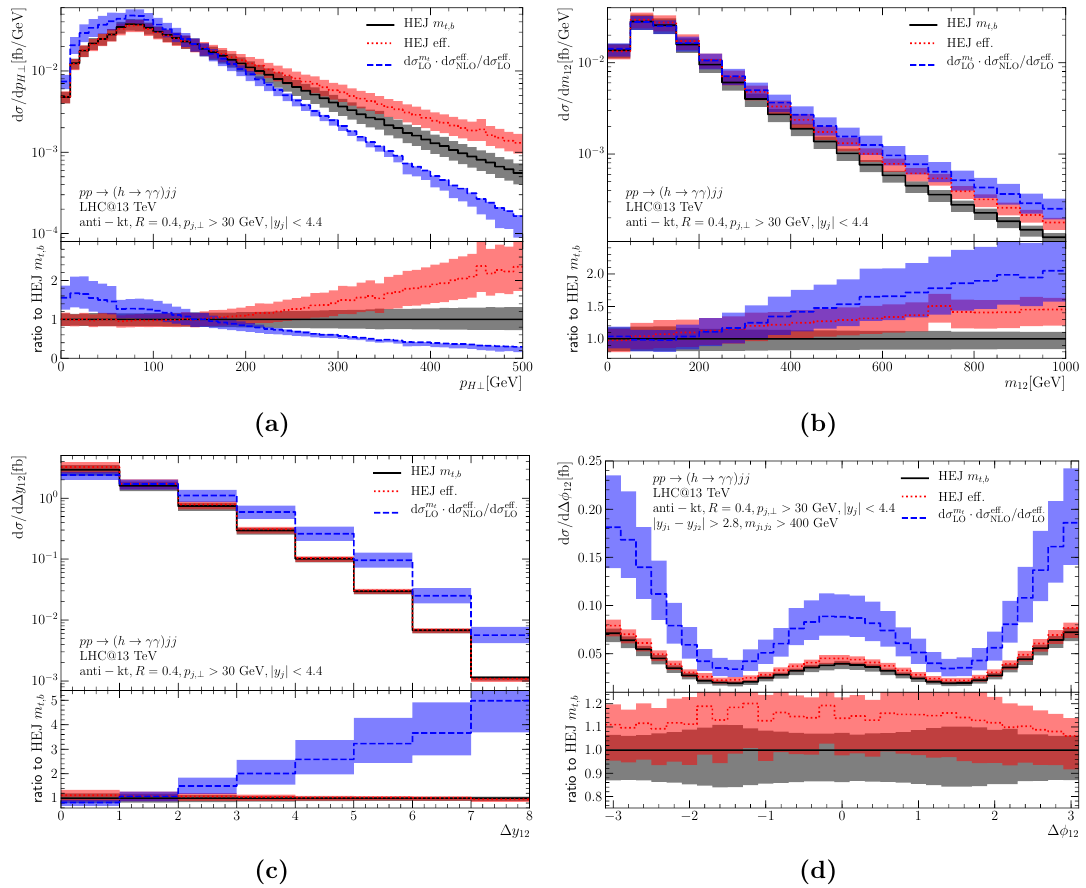
Figure 11 . The results obtained with HEJ compared with (cid:12)xed order for various key distributions. See text for further